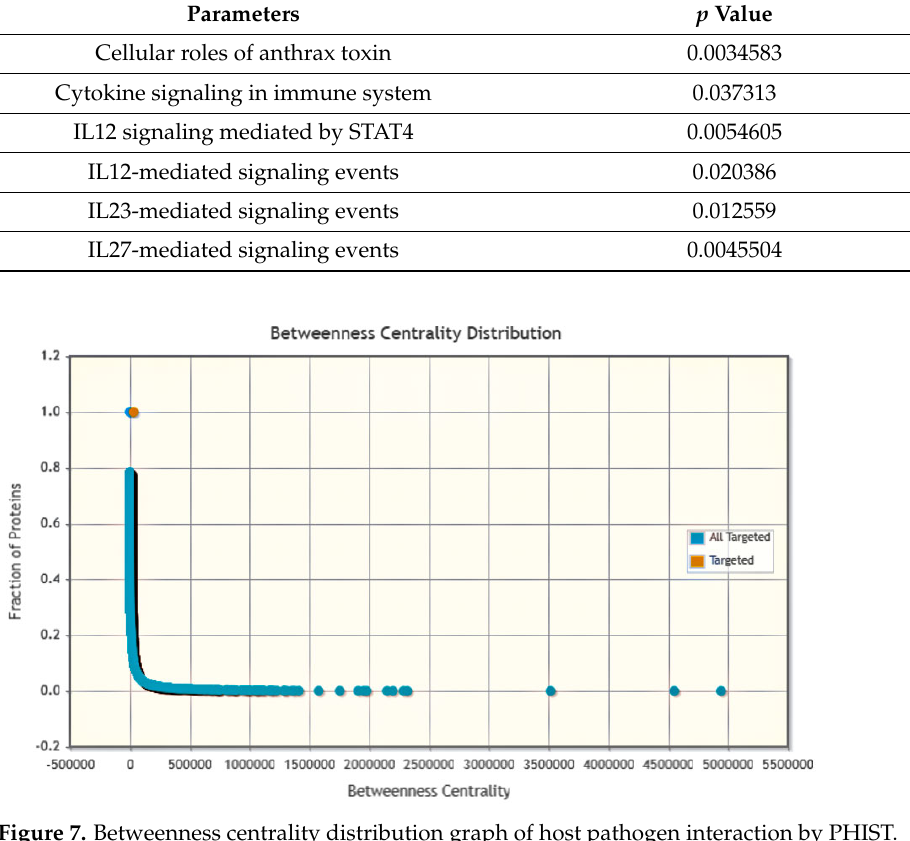
Figure 7. Betweenness centrality distribution graph of host pathogen interaction by PHIST.